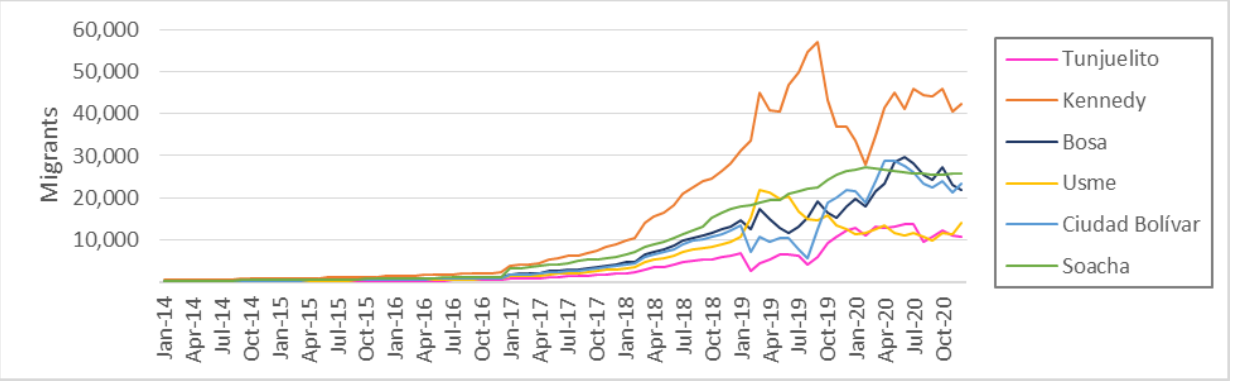
Figure 8. Historical estimate for number of migrants obtained by the statistical approach for the localities being studied.